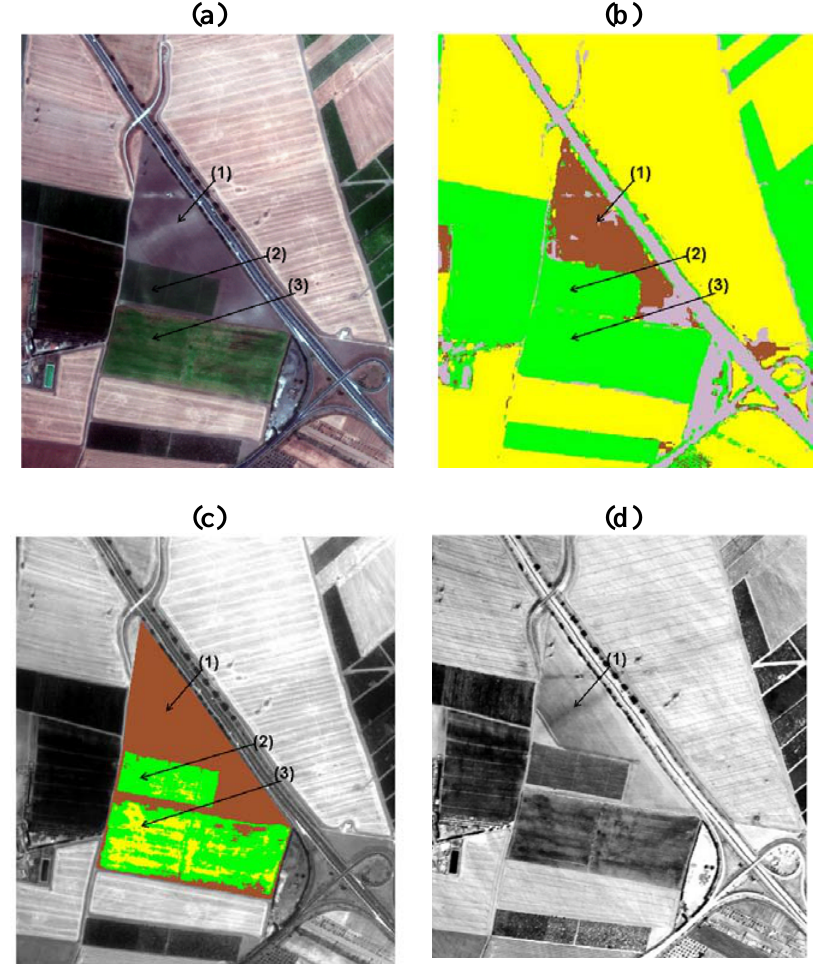
Figure 2. (a) Example of three test sites with the archaeological spectral anomalies (black arrow) detected on MIVIS imagery of Arpi (Italy). (b) SAM results for the same area (the yellow, green, grey, maroon colors depict the dry vegetation, photosynthetic green crop, artificial surfaces and bare soil, respectively). (c) LSU results for the three test sites (the brown color depicts the anomaly(1)-background system covered by more than 75 % of bare soil; the green color depicts the anomaly (2)-background system covered by more than 75 % of photosynthetic green crop; the yellow color shows the anomaly(3)- background system covered by a mixture of bare soil and green crop endmembers ranging between 25 % and 75 %). (d) MIVIS TIR image for the same test sites (MIVIS bands 93 only for visualization